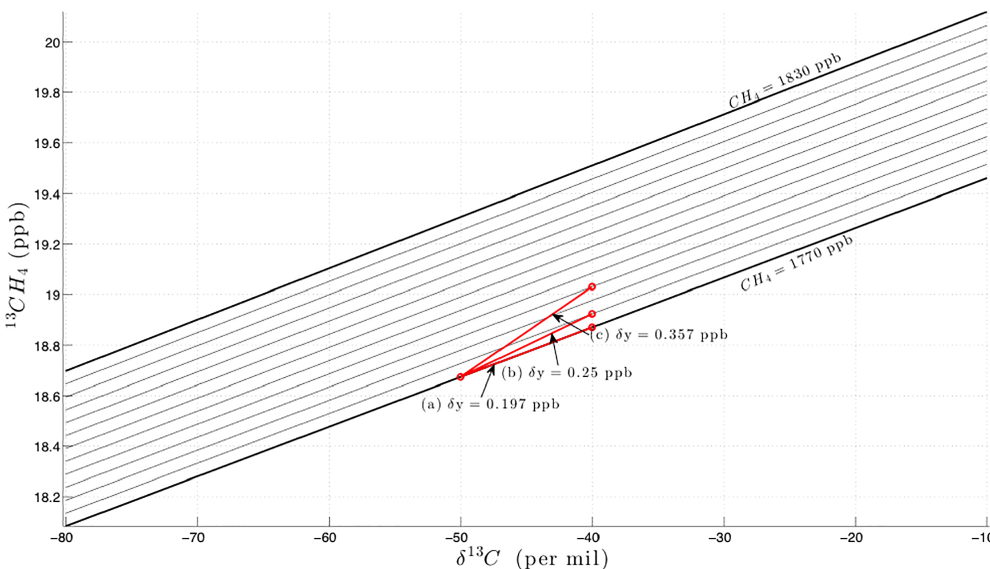
Figure 1. Range of expected terrestrial 13 CH 4 values ( y axis) given a range of CH 4 values between 1770 and 1830ppbv, and δ 13 C between 13 C range. There − 80 and − 10‰ ( x axis). The diagonal solid lines represent the 12 CH 4 values for a given CH 4 value, while varying the δ are 13 12 CH 4 lines representing the CH 4 range in 5ppbv steps. The red line (a) shows the 13 CH 4 change between − 50 and − 40 δ 13 C for a CH 4 of 1770ppb; line (b) is as line (a) but includes a CH 4 change of 5ppbv; line (c) is as lines (a) and (b) but includes a CH 4 change of